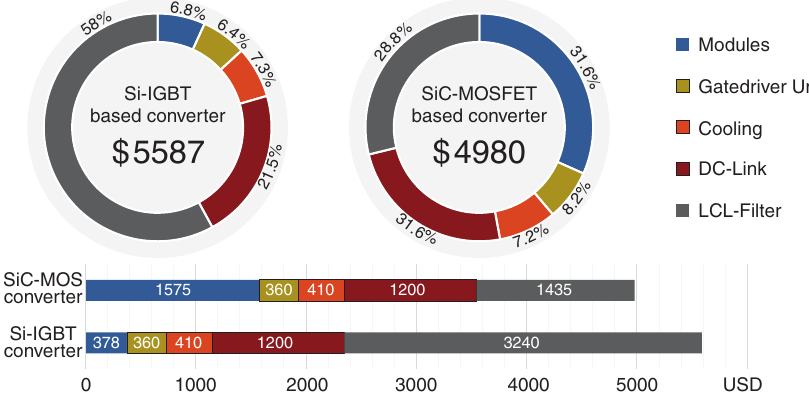
Figure 17. Comparison of percentage and total cost distribution of both converter